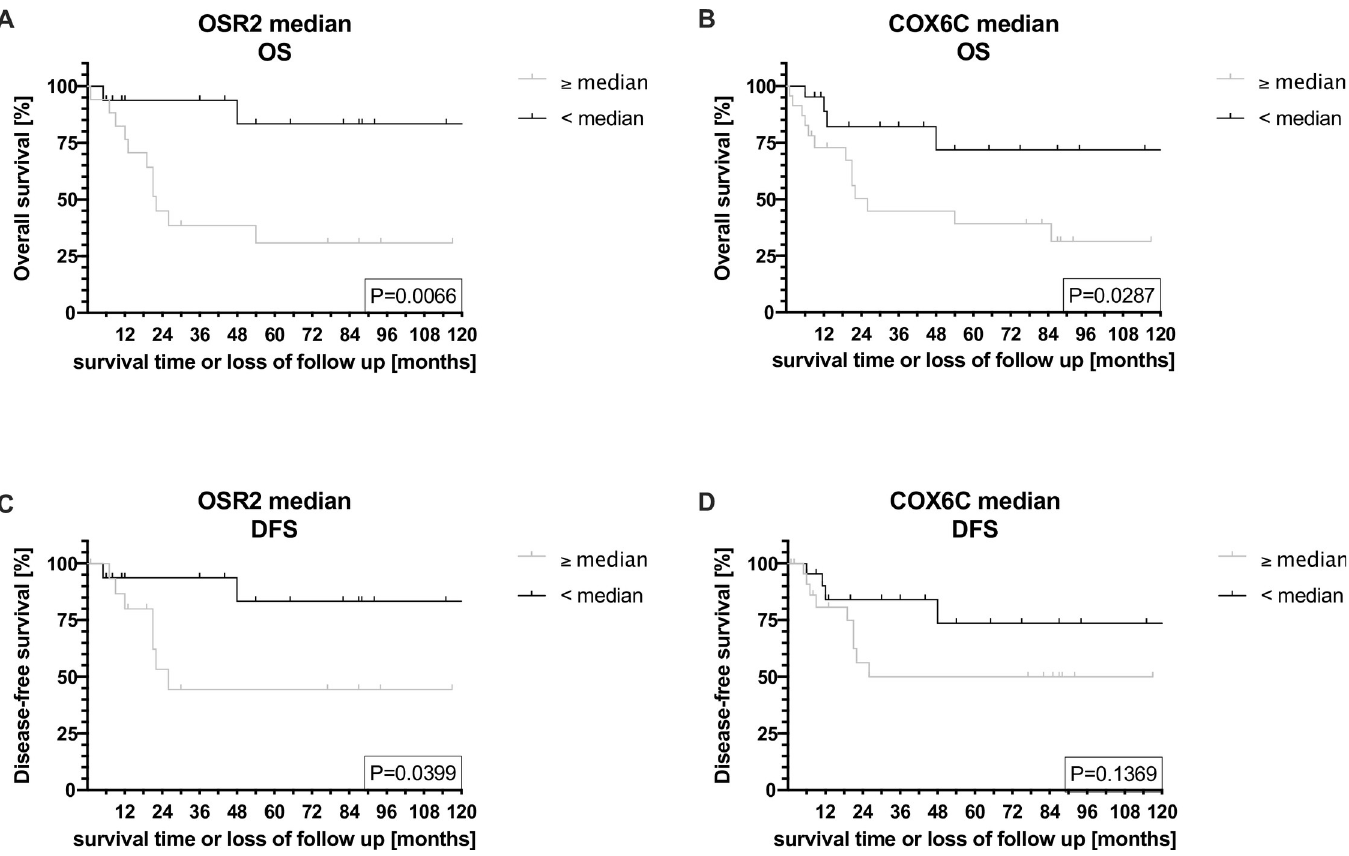
Fig 4. COX6C and OSR2 are independent prognostic factors for survival in RT-qPCR data.